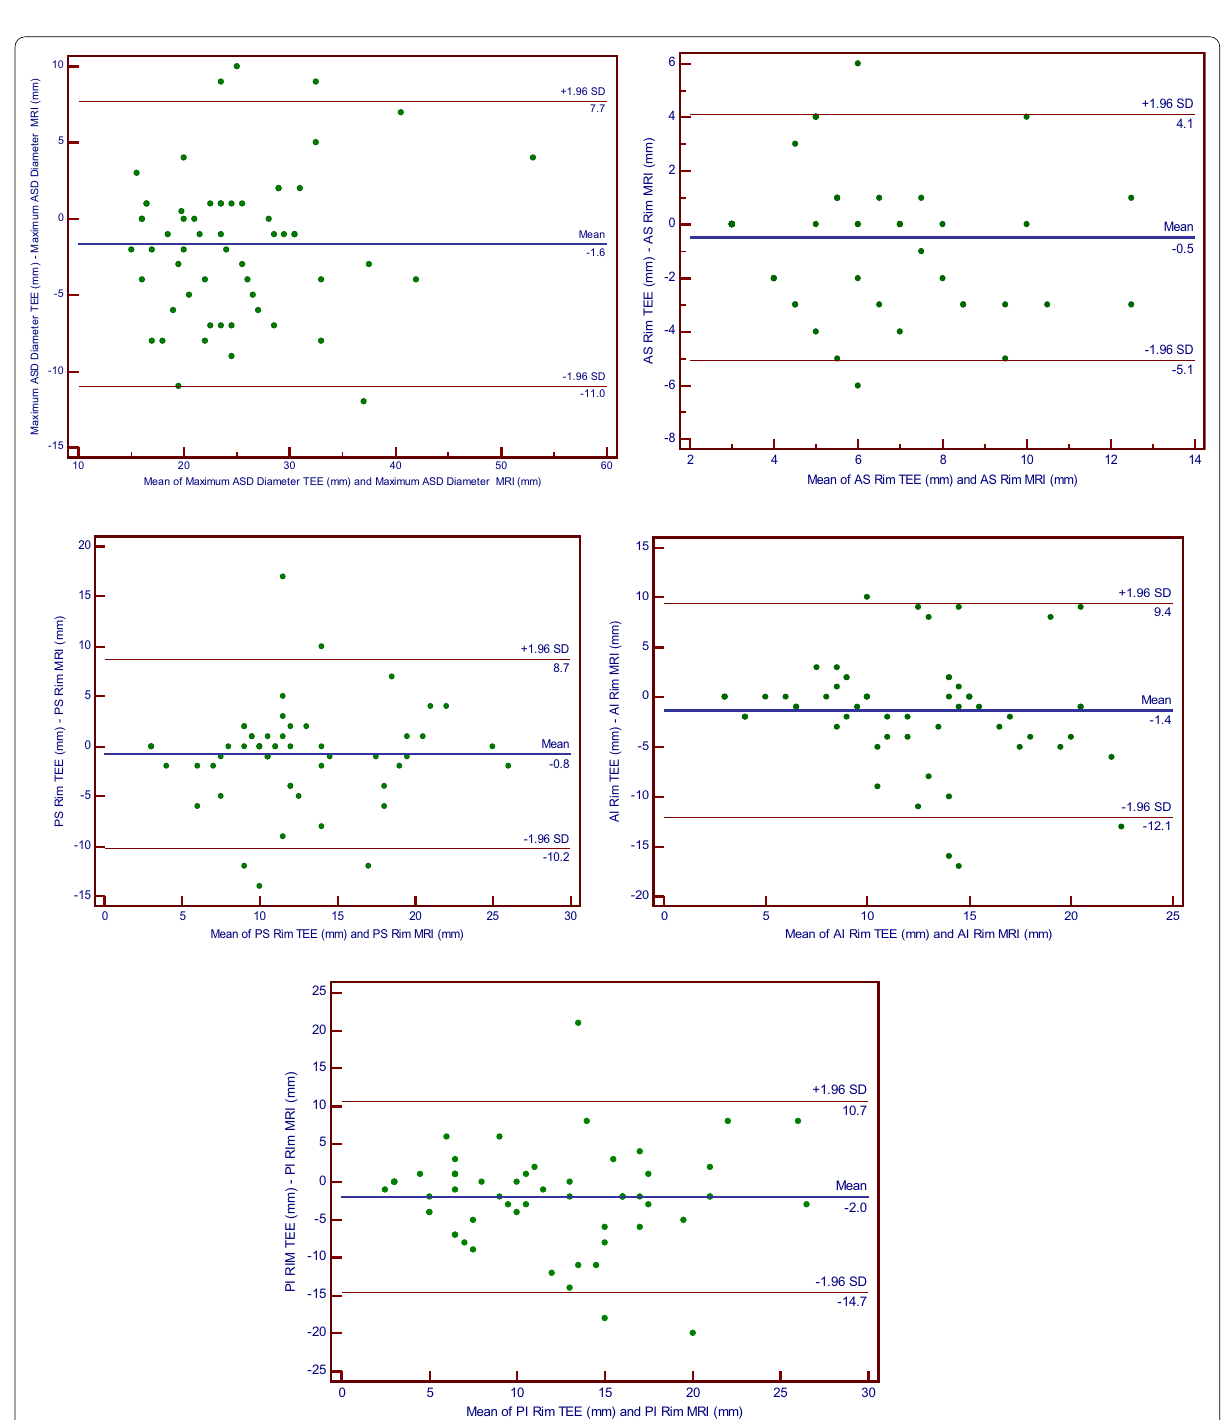
Fig. 1 Bland Altman plot for agreement of modes of measurement between TEE and CMR for Maximum ASD diameter and rim sizes. Note: ASD, Atrial Septal Defect; TEE, Transesophageal Echocardiography; MRI, Magnetic Resonance Imaging; AS, Anterosuperior; PS, Posterosuperior; AI, Anteroinferior; PI,